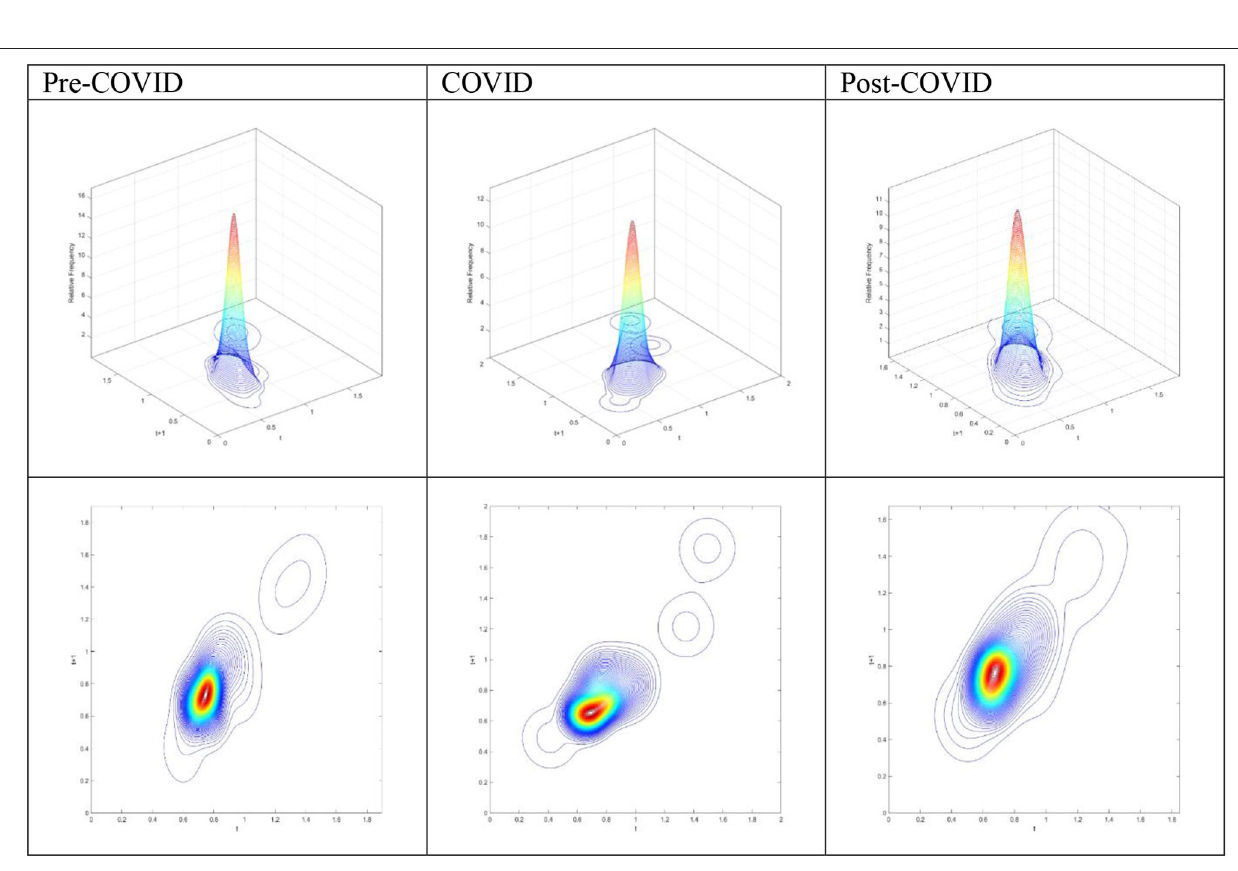
of the Post-COVID period have been recovered to the Pre- COVID